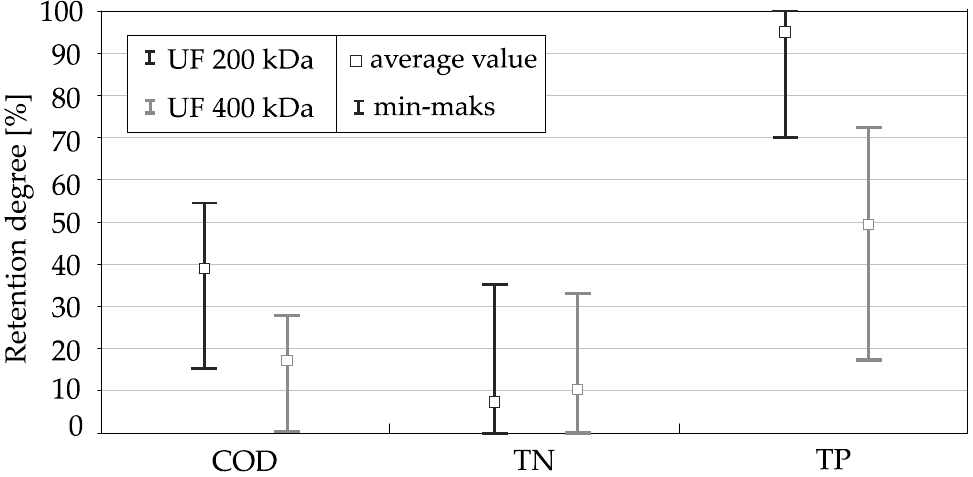
Figure 3. Comparison of retention coefficients of selected chemical parameters (chemical oxygen demand—COD; total nitrogen—TN; total phosphorus–TP) of biologically treated wastewater subjected to membrane filtration with the use of ultrafiltration membranes with separation of 200 kDa and 400 kDa.